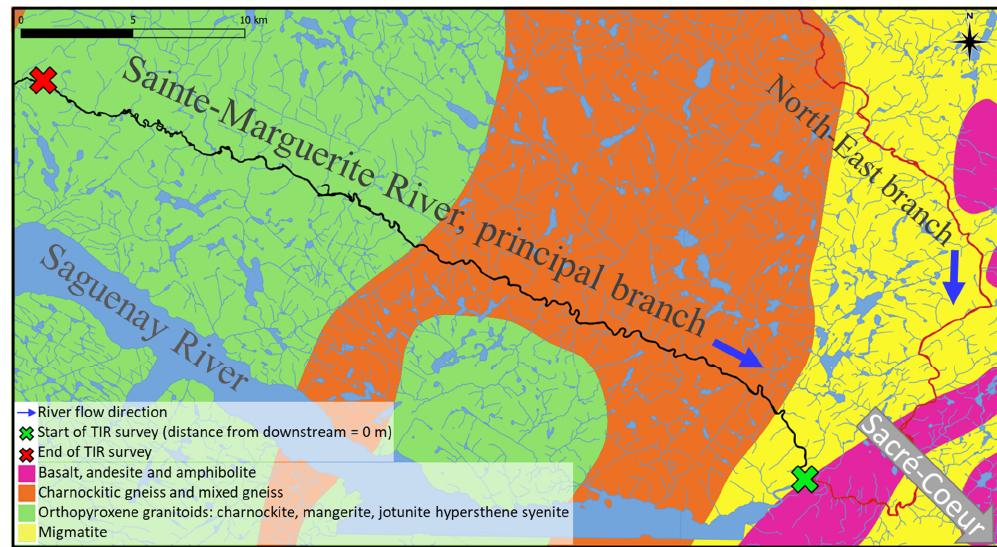
Figure 2. Bedrock geology across the Sainte-Marguerite River (based on [36]).